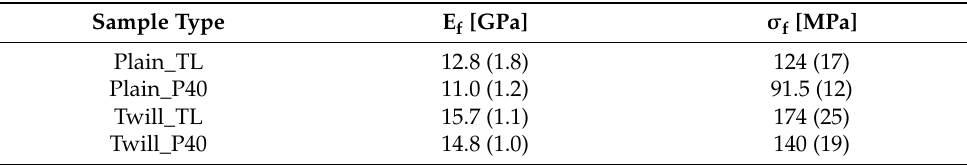
Figure 2. Representative flexural stress-strain curves for all investigated materials. Table 1. Mean values of flexural modulus (E f ) and maximum flexural strength ( σ f ) for each sample type. Standard deviations are reported in brackets.